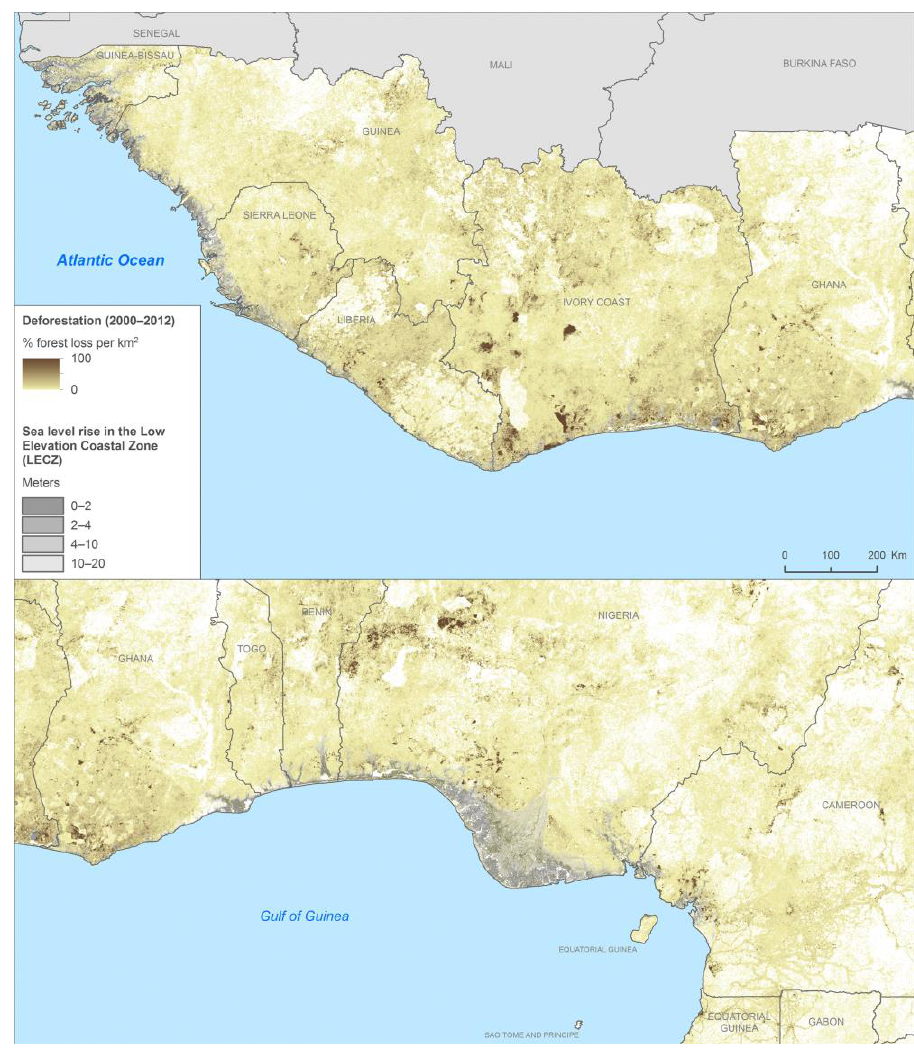
Figure 9. Landsat-scale deforestation data aggregated to one square kilometer